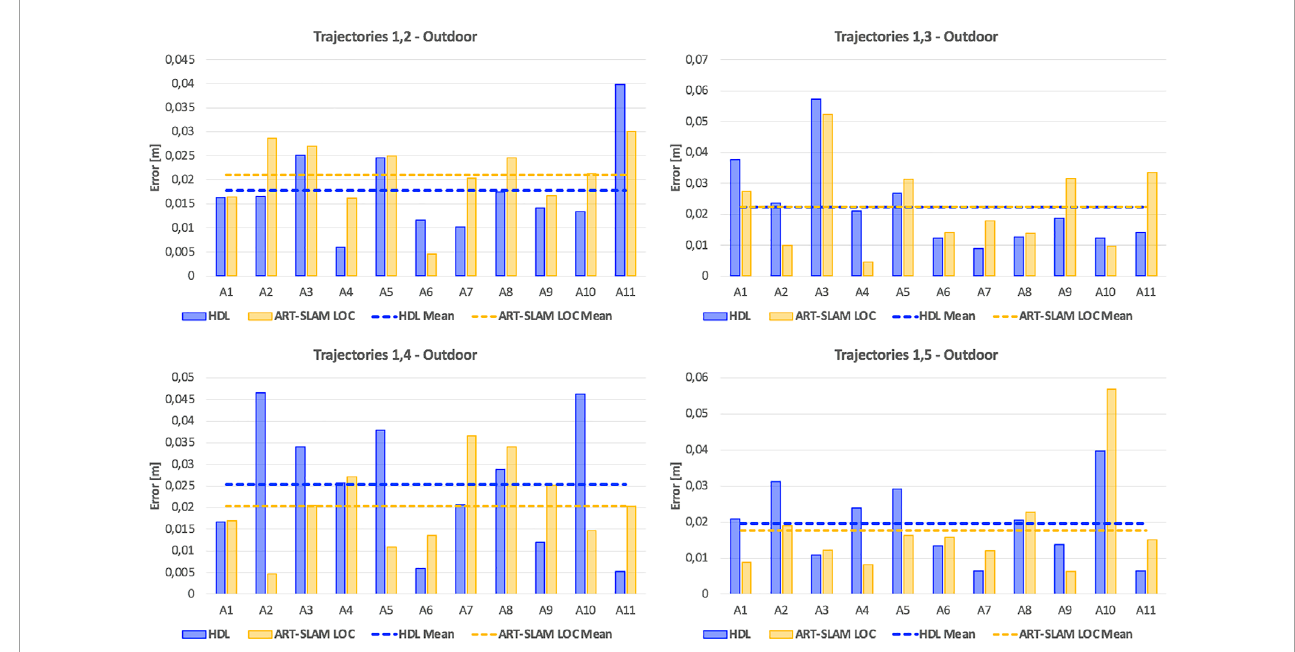
FIGURE 8 Translation re-localization errors of the outdoor experiment, using HDL Koide et al. (2019) and ART-SLAM Frosi and Matteucci (2022). The accuracy of both systems is